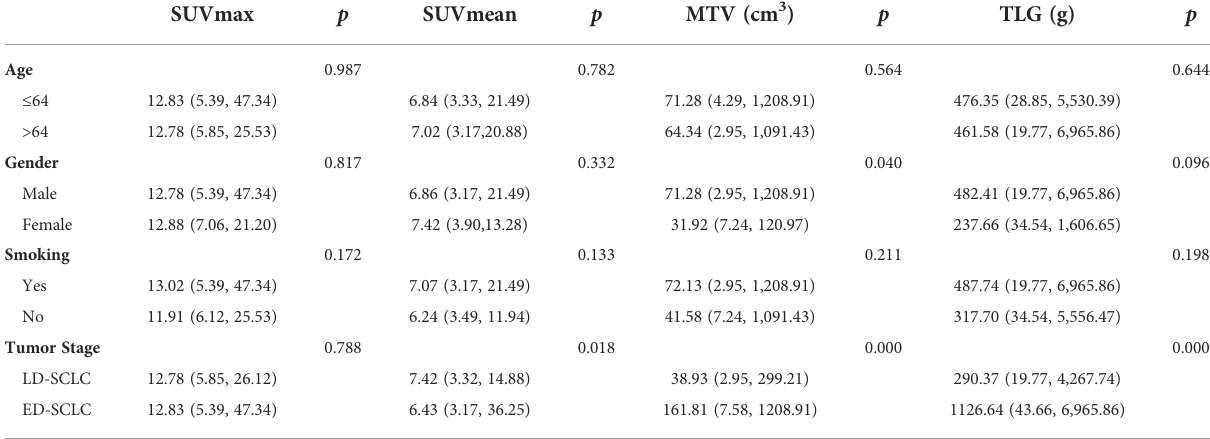
TABLE 3 Analysis of metabolic parameters of SCLC on PET/CT scanning ( n = 119).